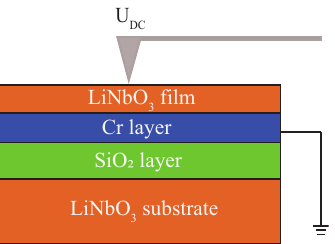
Figure 1. Schematic diagram of nano-domain writing in lithium niobate film on insulators (LNOI) under an atomic force microscope (AFM)-tip